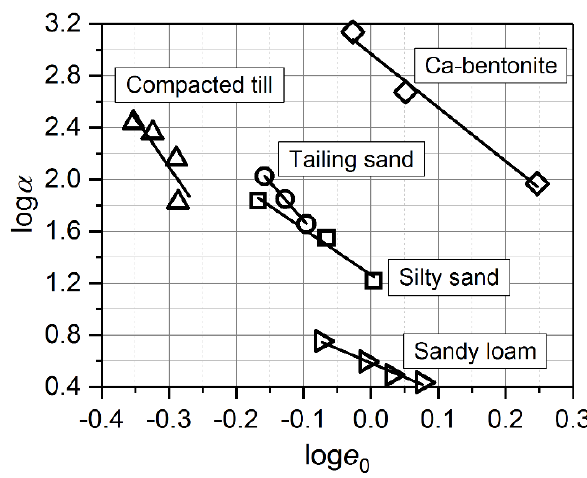
Figure 4. Linear relationship between log e 0 and log S r for five investigated soils.